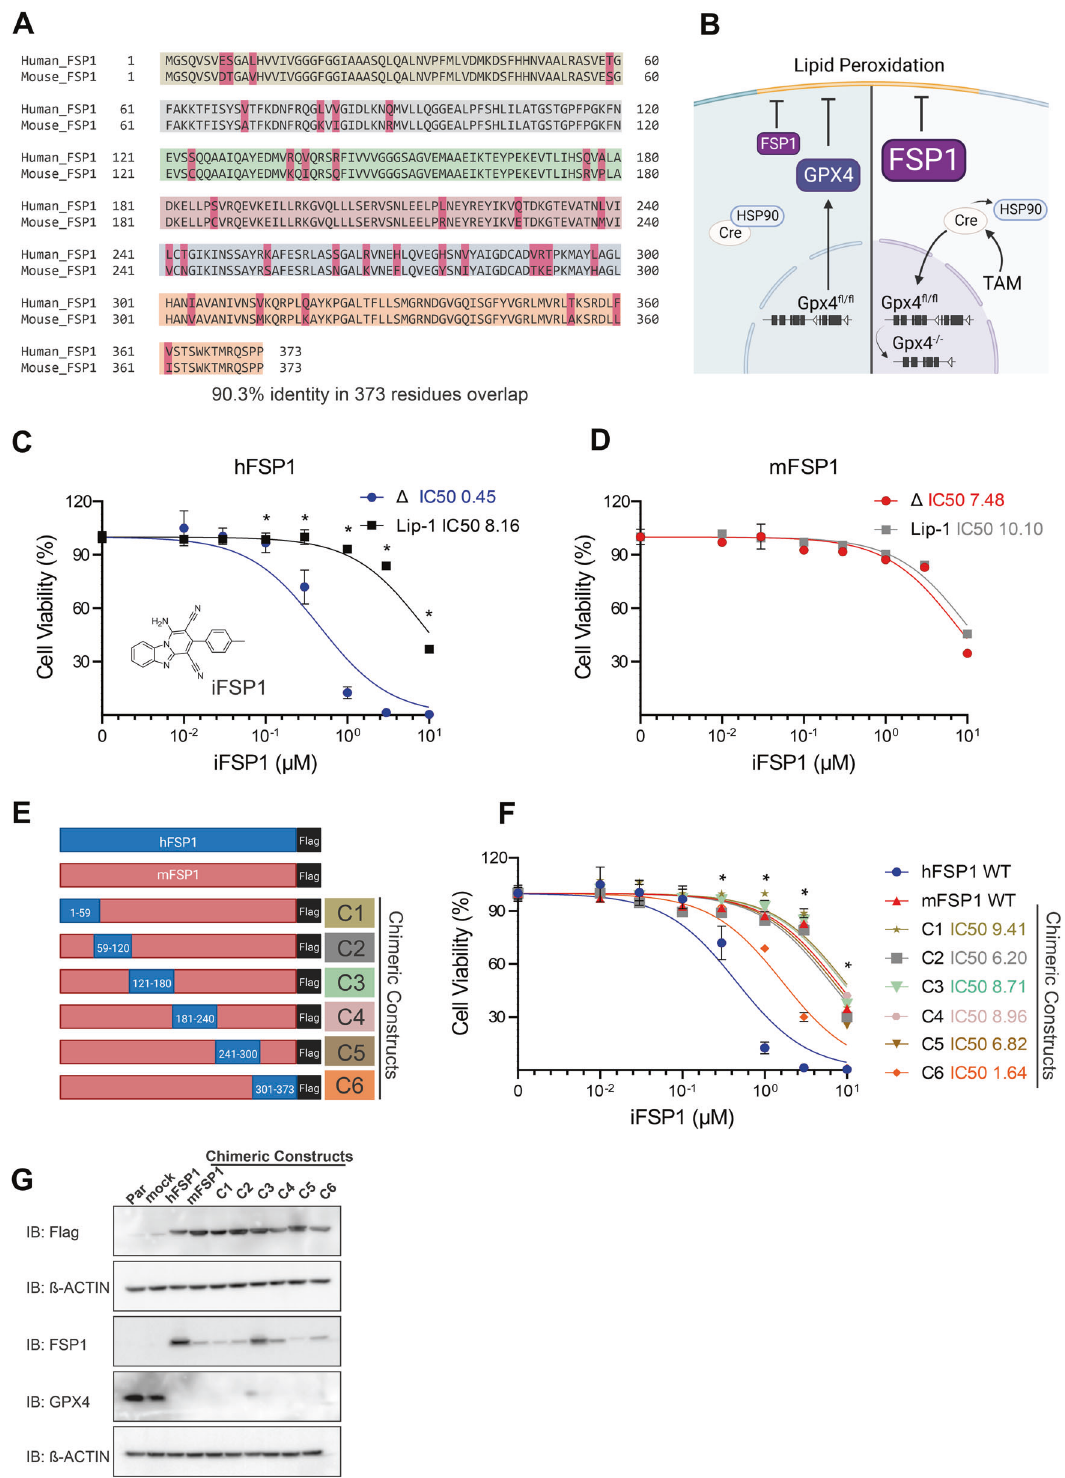
inhibitor liproxstatin-1 (Lip-1) (Fig. 1C). To provide additional insights into this feature we designed six chimeric constructs where distinct segments of the murine protein were replaced by the corresponding human counterparts (Fig. 1E). Brie fl y,